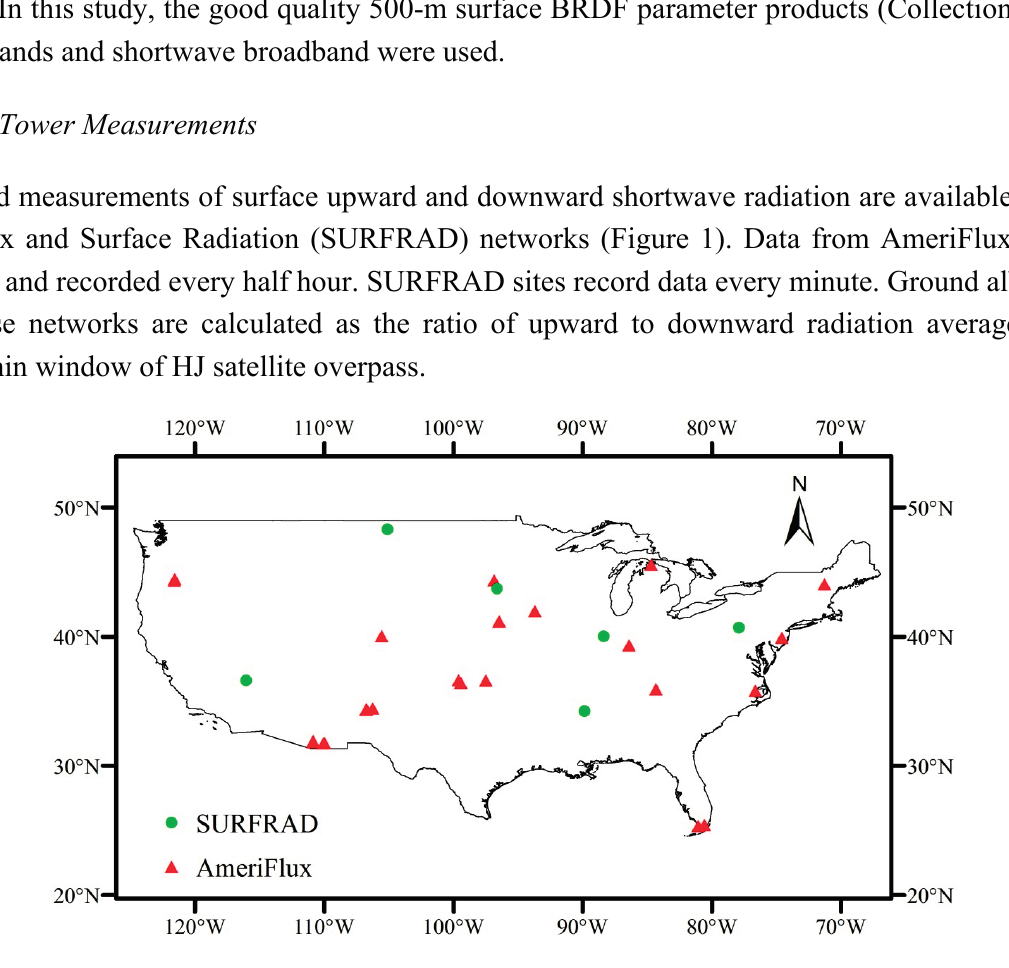
Figure 1. Location of the flux sites from AmeriFlux and SURFRAD